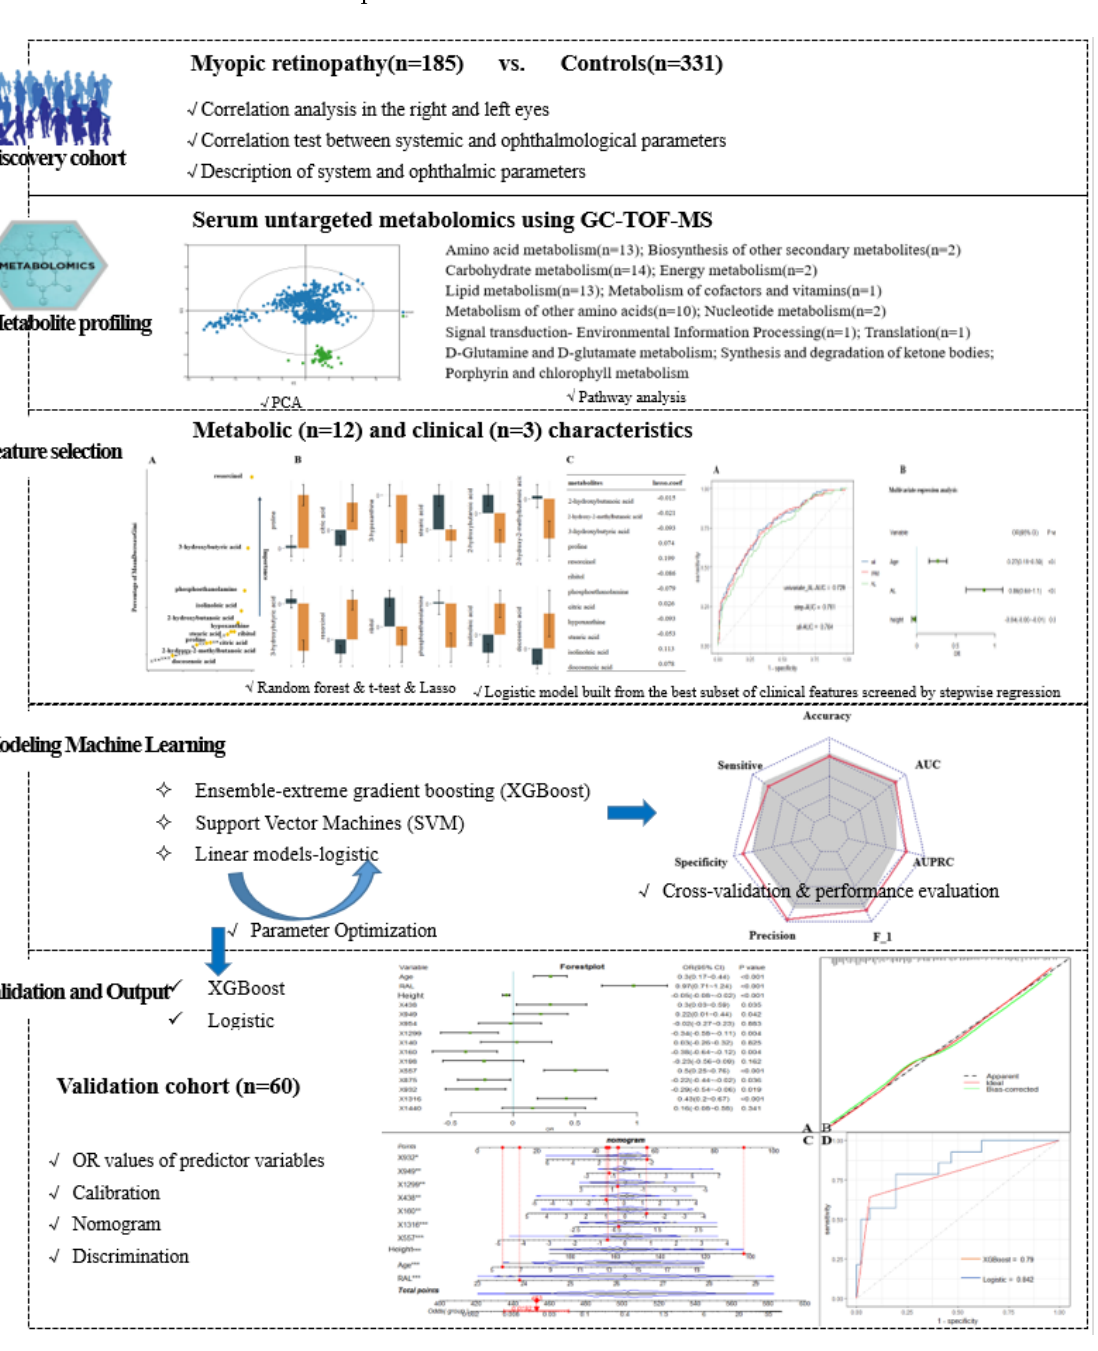
Figure 1. Study workflow and design.